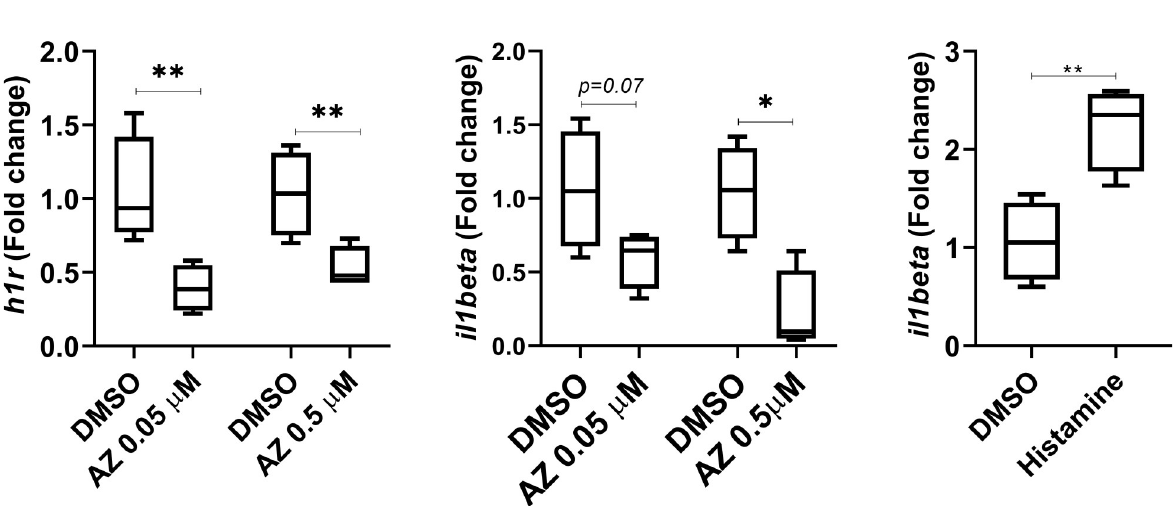
Fig 3. Decrease of histamine receptor 1 ( HR1 ) and proinflammatory IL-1 β expression by addition of azelastine to an ex vivo lymph node explant culture of BALB/c mice infected with Leishmania major . Addition of histamine increased the expression of IL-1 β . Determinations were made using quantitative PCR. ( � p = 0.05; �� p = 0.01).